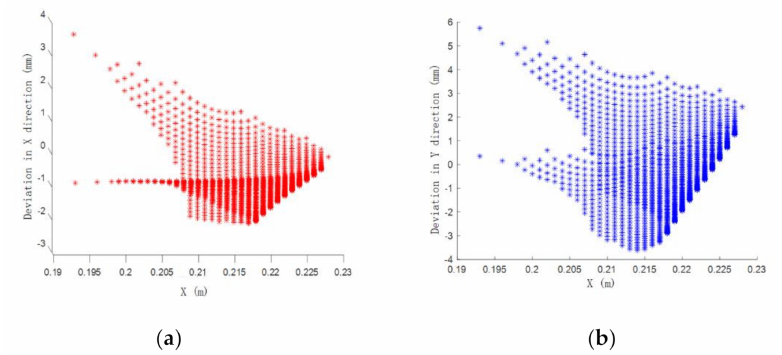
Figure 10. The deviation of the tip position caused by the cable length error seen from X direction: ( a ) The deviation in X direction; ( b ) the deviation in Y direction.